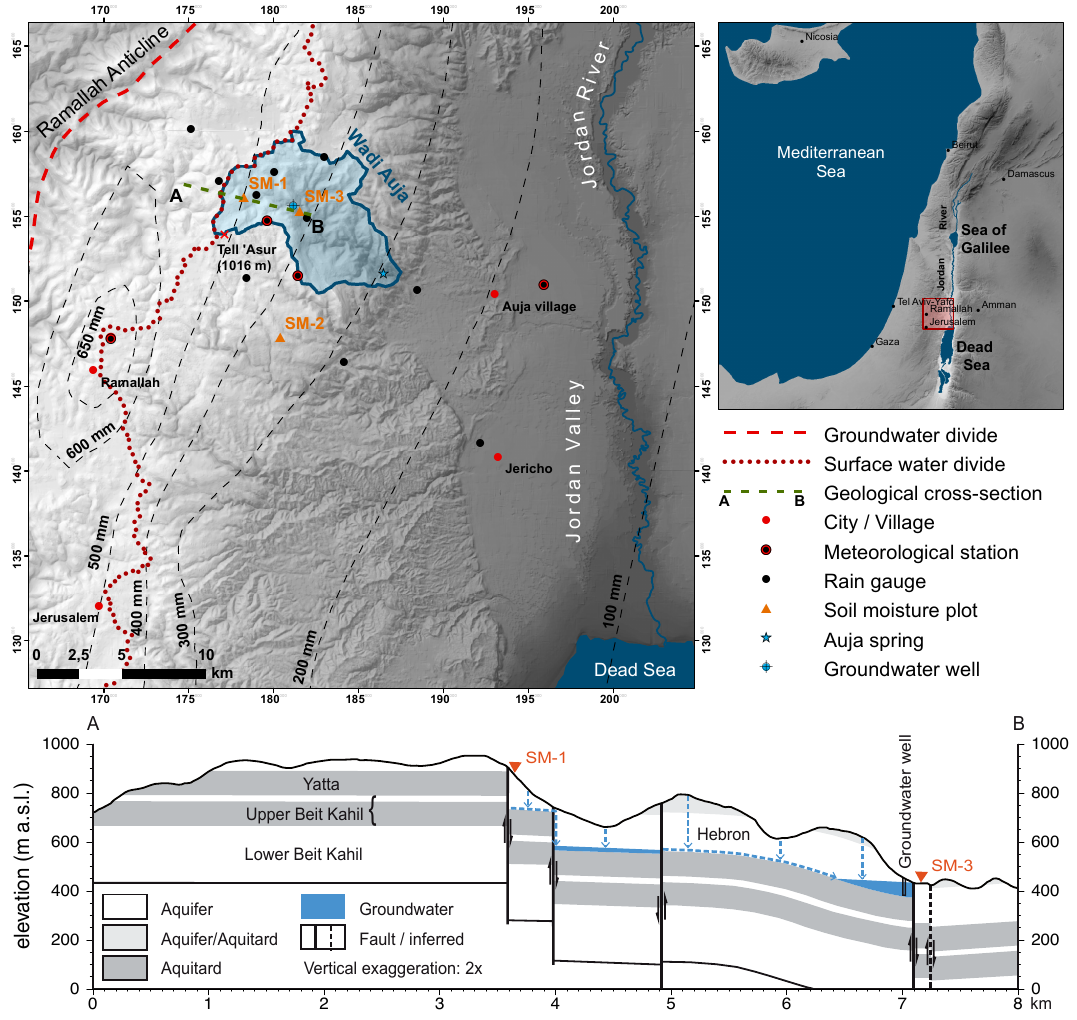
Figure 1. Study area with location of meteorological stations, rain gauges, soil moisture plots (SM-1, SM-2, SM-3) and isohyets of long-term average annual rainfall ( ≥ 20 years) according to data from ANTEA (1998). Coordinates in the detailed map are in Palestinian Grid format. In the upper slope sections of Wadi Auja a local perched spring aquifer formed which is tapped by an abstraction well.